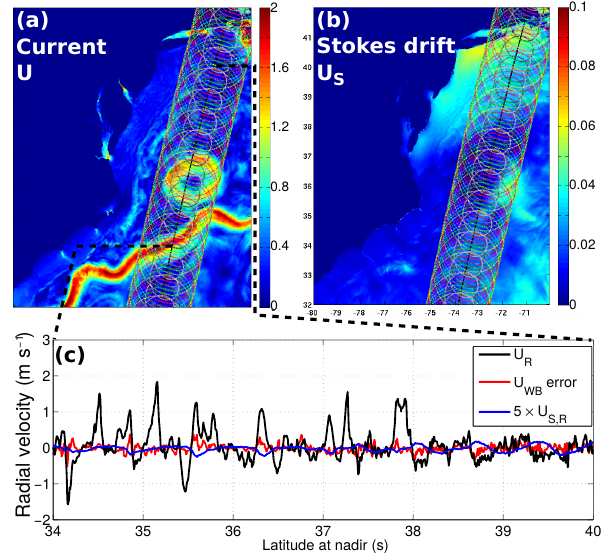
Figure A2. Example of (a) current in the Gulf Stream and asso- ciated (b) Stokes drift and (c) errors for the estimation of U WB for beam 8 (12 ◦ incidence, green circles in a and b ). In this ex- ample the standard deviation of err WB is 10cms − 1 , which is on the order of 5 U S , R . Note that the measured geophysical Doppler is U GD = U WB + GU S , R with G (cid:39) 25.